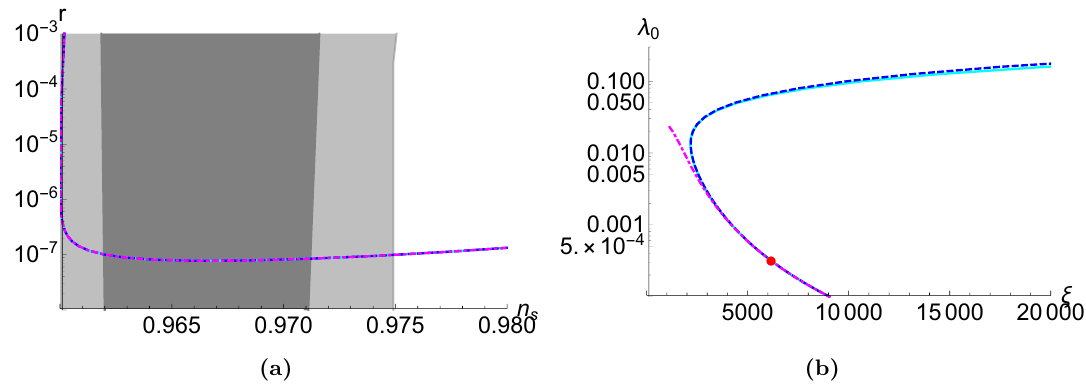
Figure 4 . Palatini formulation: zoom of r vs. n s (a) for r ≤ 10 − 3 and λ 0 vs. ξ (b) for λ 0 ≤ 0 . 3 . The color code is the same as in figure